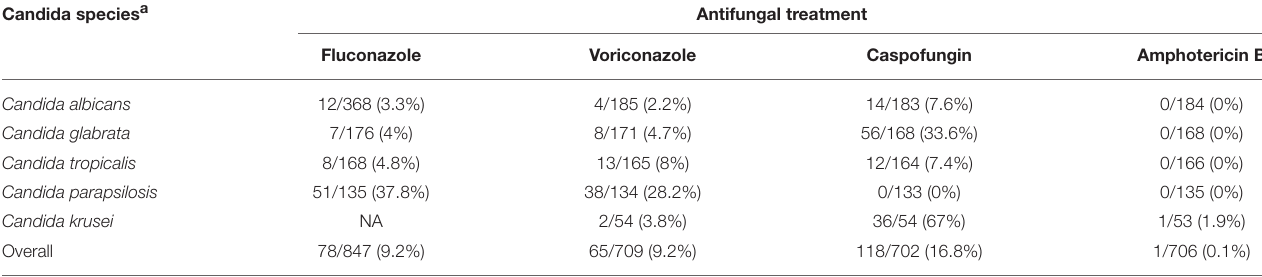
TABLE 1 | Resistance to antifungal therapy during the study